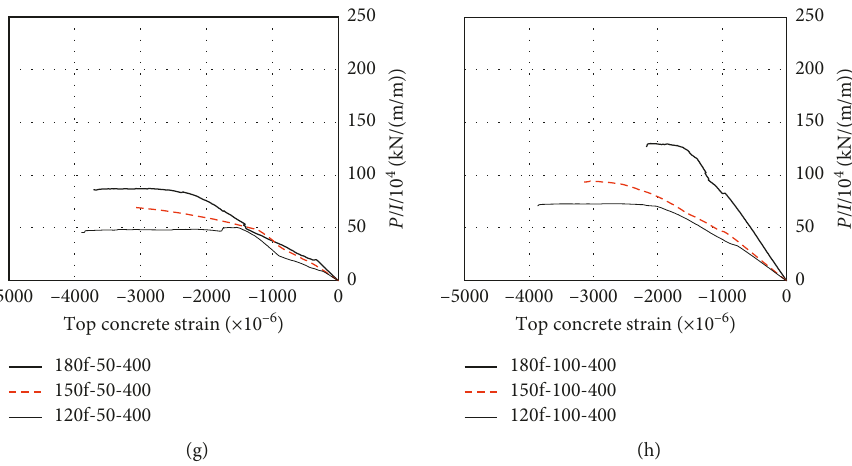
Figure 7: Load-concrete strain curves at top of slab for the specimens. (a) Slab thickness, stud spacing (50 mm, 50mm); (b) slab thickness, stud spacing (100mm, 50 mm); (c) slab thickness, stud spacing (50mm, 100mm); (d) slab thickness, stud spacing (100mm, 100mm); (e) slab thickness, stud spacing (50 mm, 200mm); (f) slab thickness, stud spacing (100mm, 200mm); (g) slab thickness, stud spacing (50mm, 400mm); (h) slab thickness, stud spacing (50mm, 400